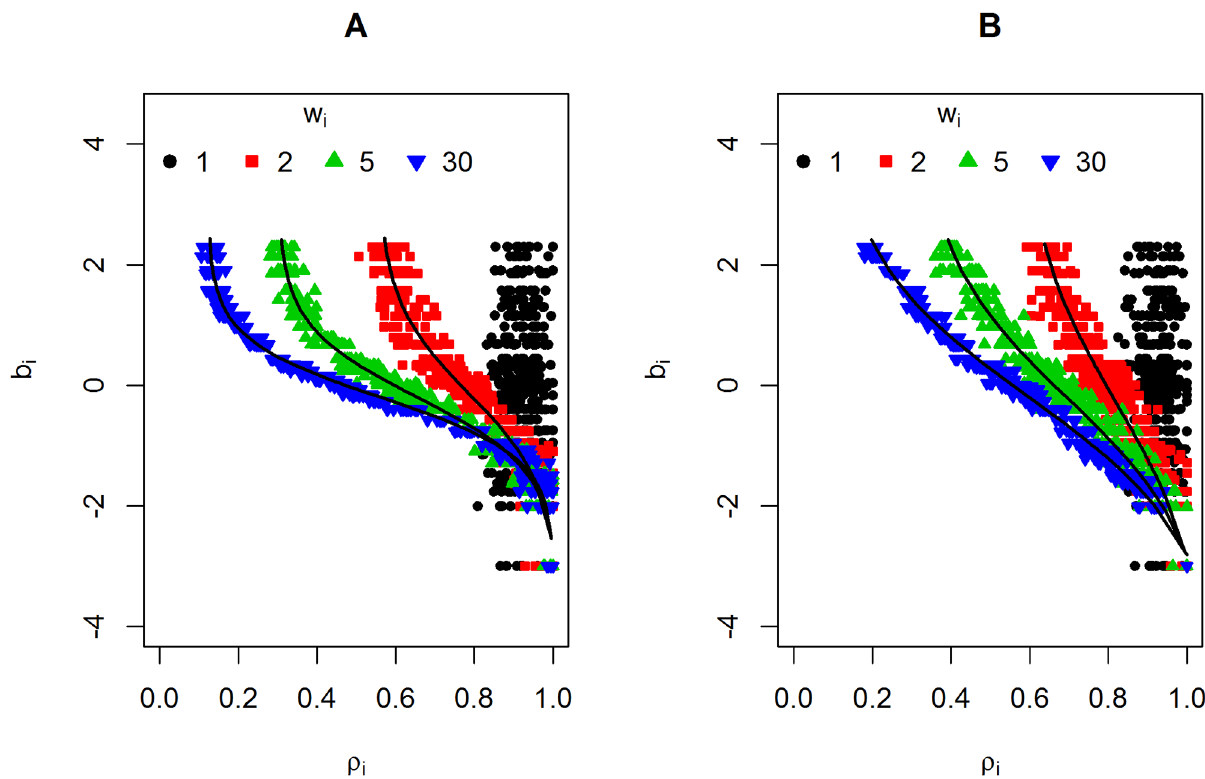
Fig 2. Item difficulty versus the first eigenvector of matrix O. (A) Scenario 2. (B) Scenario 3. The black lines represent the proposed function (Eq 22).